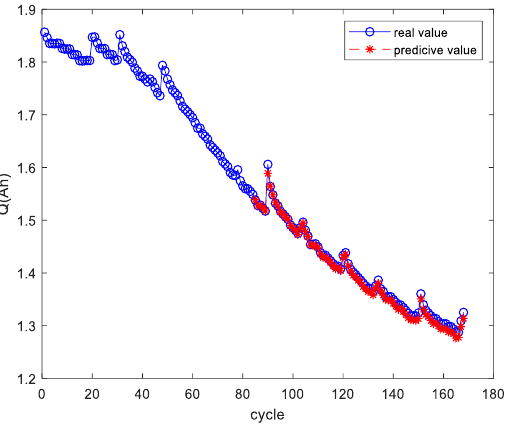
Figure 5. B5 battery capacity estimation